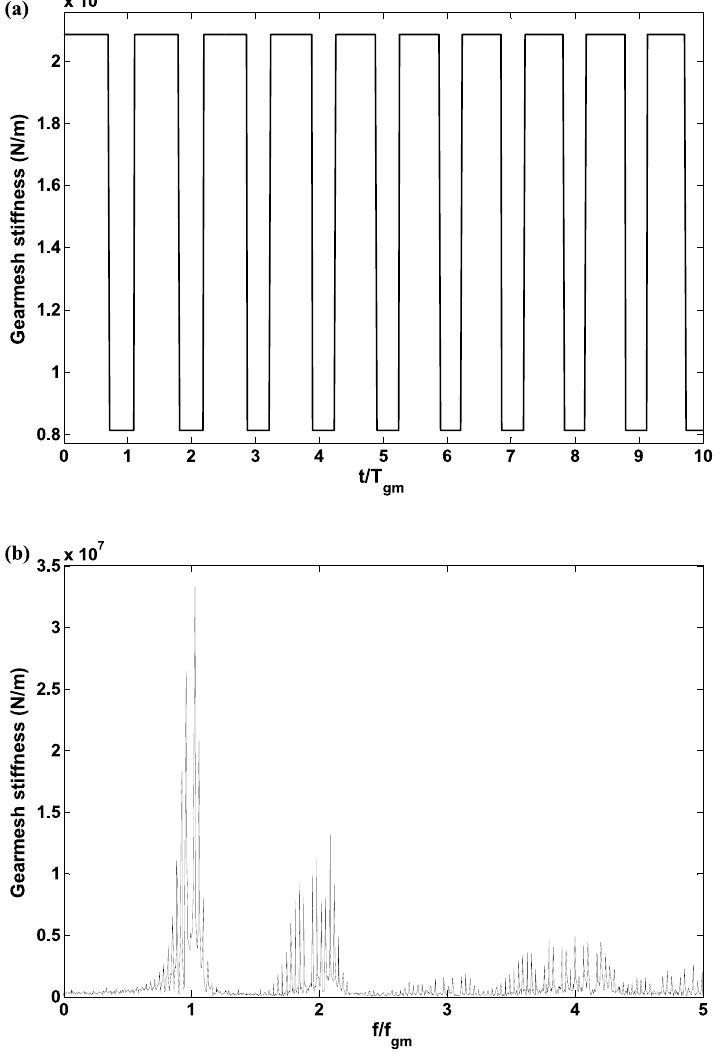
Fig. 8. (a) Gearmesh stiffness function (b) Spectrum of the variable part of the gearmesh stiffness